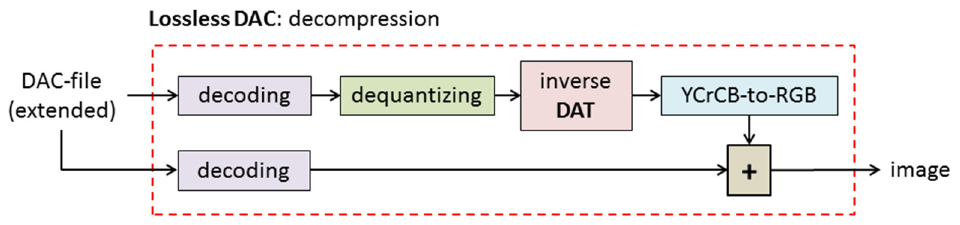
Figure 4. Lossless DAC: decompression of full-color digital image.